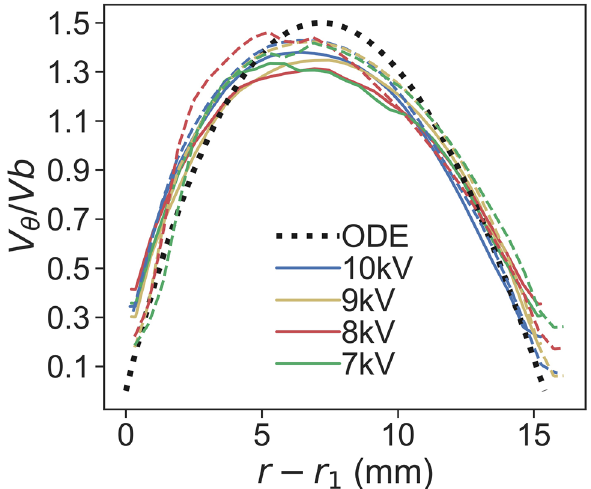
Fig. 6 Azimuthal velocity profiles normalized by the bulk veloc- ity for SO50 (solid lines) and SO100 (dashed lines), at 4 different corona voltages, compared with the normalized ODE solution. A clear collapse is seen with a peak-to-bulk ratio of approximately 1.5 at the center of the